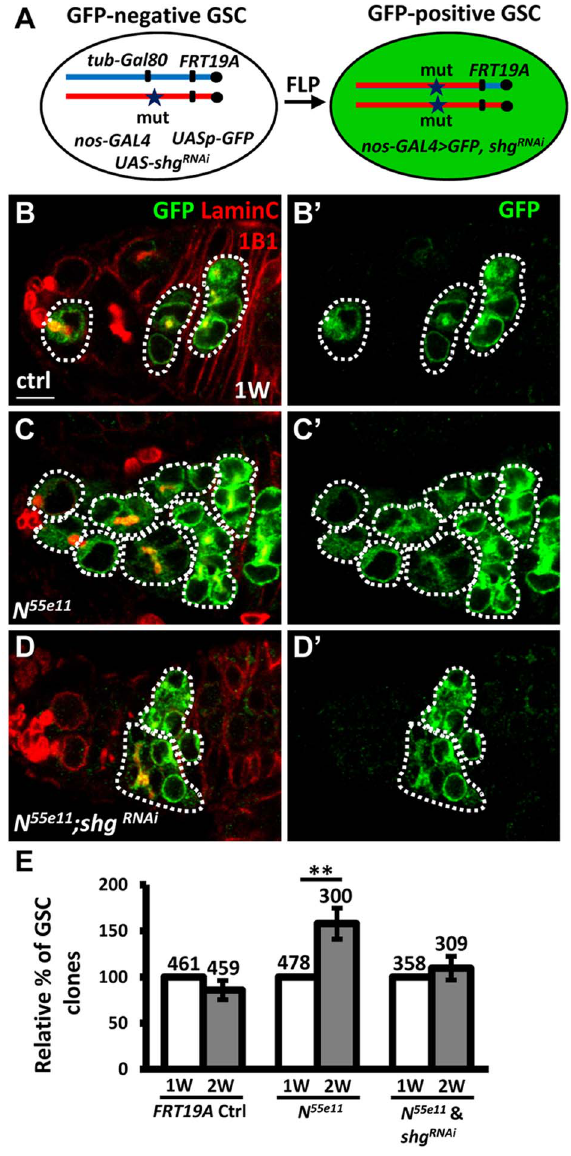
Fig. 4. Notch signaling controls GSC-niche adhesion via E- cadherin. (A) Mitotic recombination was used to generate GSCs lacking N and Gal80 (Gal80 suppresses GAL4 expression). Females carried a wild- type (wt) allele linked to a tub-GAL80 transgene in trans with an N mutant (mut) allele on one X chromosome, and non-GAL4 , UASp-mCD8GFP , and UAS-shg RNAi on the third chromosome. FLP-mediated recombination between FRT sites during mitotic division generated an N homozygous mutant cell lacking GAL80 (identifiable by the presence of GFP expression), which enabled transcription of GFP and shg RNAi via the binding of GAL4 onto UAS elements. (B–D) One-week (w)-old mosaic germaria with GFP (green, mutant cells), 1B1 (red, GSC fusomes), and LamC (red, cap cell nuclear envelopes) labels. GFP-positive ( + ) GSCs and their daughter cells are outlined by dashed lines. Control (ctrl) germarium (B) contains one wt and one GFP + GSC and their progeny, N 55e11 mutant germarium (C) contains two GFP + GSCs (full GSC clone) and their progeny, while shg RNAi -knock down N 55e11 mutant germarium (D) contain no GFP + GSCs, but do contain their progeny, indicating that GFP + GSCs have been lost from the niche. B 9 -D 9 show the GFP channel only. Scale bar: 5 m m. (E) Relative percentage of GSC clones (as a proportion of total GSCs) at 1 and 2w after clone induction. The number of mosaic germaria analyzed is shown above each bar. **, P , 0.01. Error bar, mean 6 SEM. The genotype of the control germaria is hs-flpneoFRT19A/GAL80FRT19A